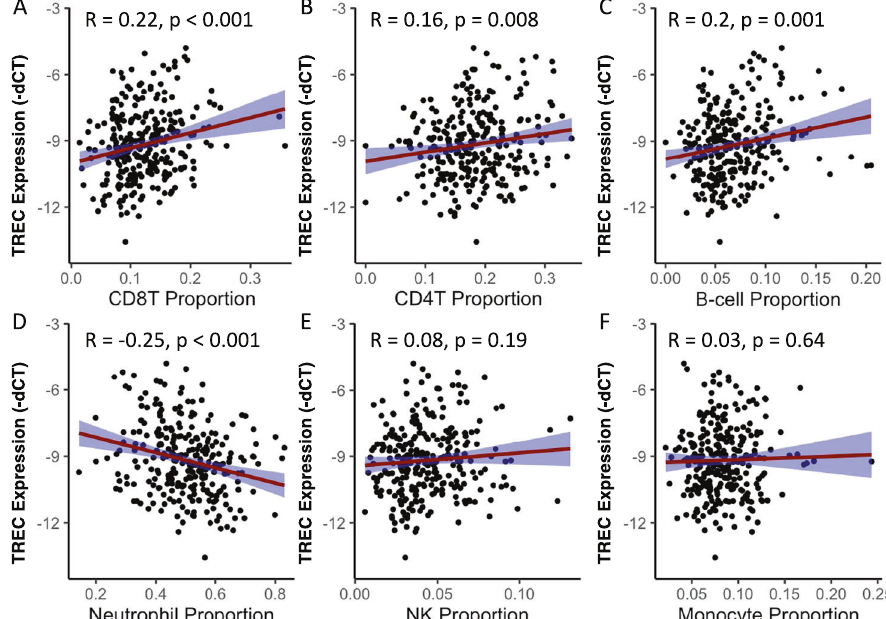
Fig. 3 Associations between TREC levels and measures of leukocyte cell composition in humans (men and women). Note that TREC data are depicted as -dCT to clarify that higher dCT integer values indicate lower levels of TRECs. Levels of TRECs were positively correlated with proportions of A CD8T cells, B CD4T cells, and C B-cells, and D negatively correlated with proportions of neutrophils. TREC levels were not correlated with proportions of E NK cells or F monocytes. N = 276.